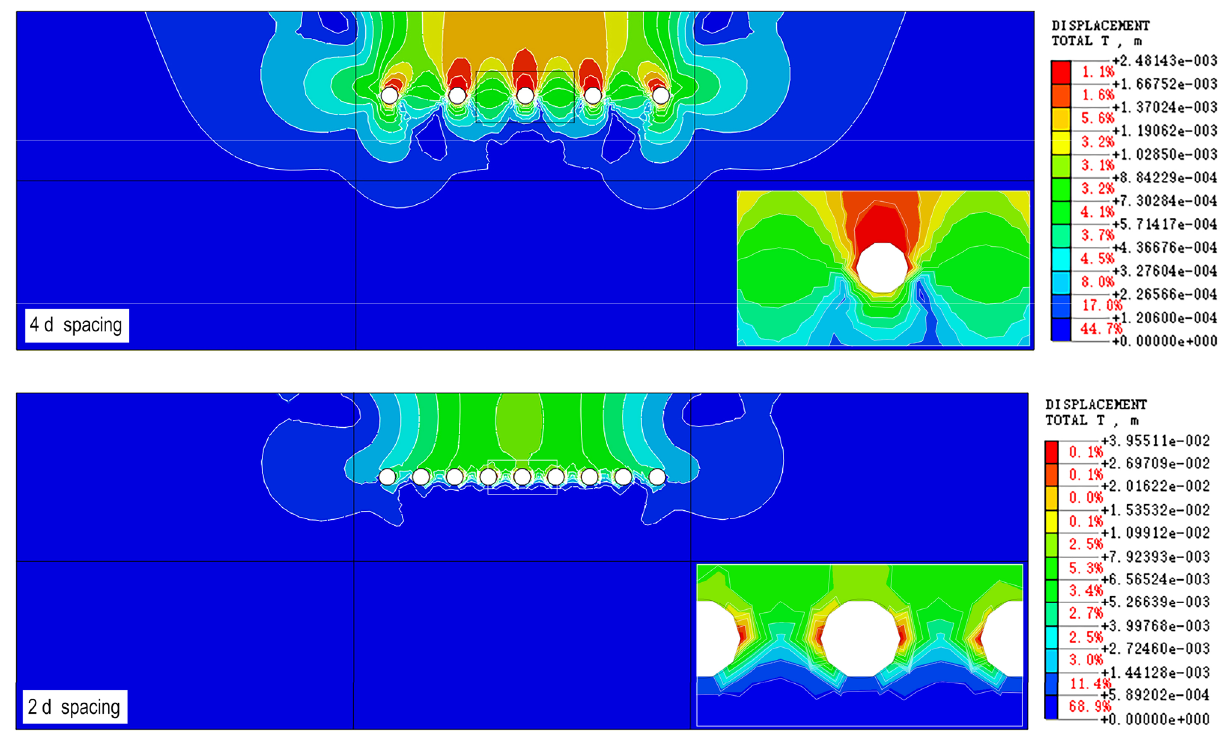
Fig. 7 Total displacement of soil extraction openings at 4 d and 2 d